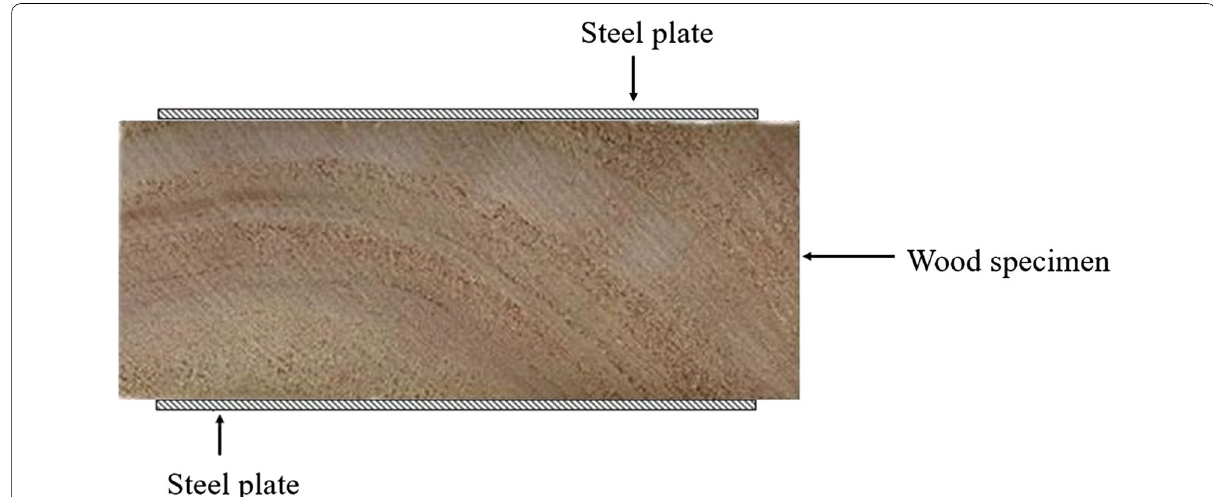
Fig. 2 Schematic diagram of fixing method of poplar board. Poplar board was fixed between two steel plates, and then wrapped in a flat polyethylene pouch and